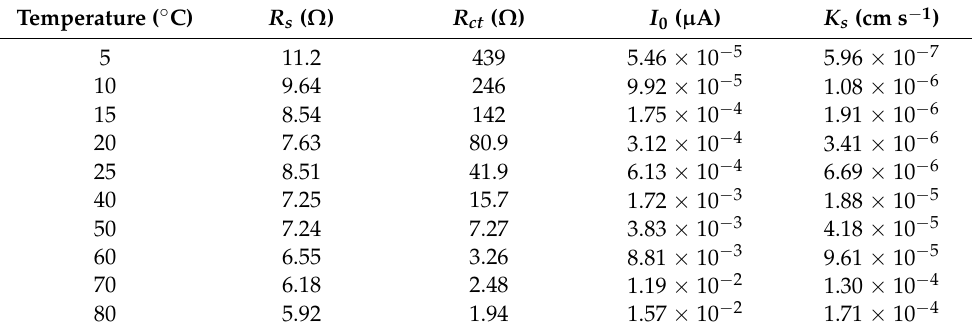
Figure 3. Equivalent circuit model of ( a ) fresh sodium half cells and ( b ) sodium half cells cycled at 100 mA g − 1 and ( c ) Nyquist plots of HC electrode at various temperature from 5 °C to 80 °C and frequency from 100 kHz to 0.1 HZ, with the high frequency part expanded in the inset. Table 1. HC sodium half-cell resistance at several temperatures measured by EIS.